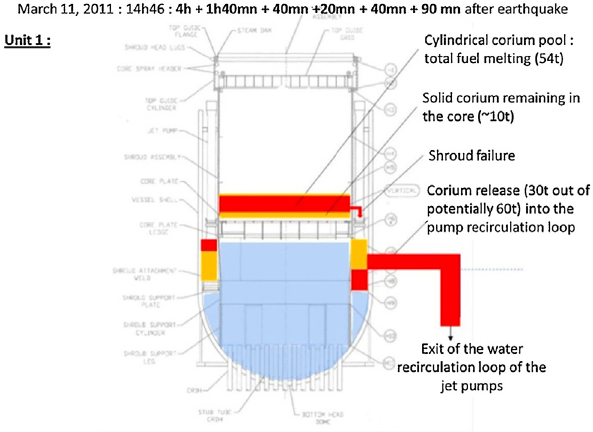
Fig. 8. Illustration of the last corium relocation from the core: ∼ 8 h 50 after the